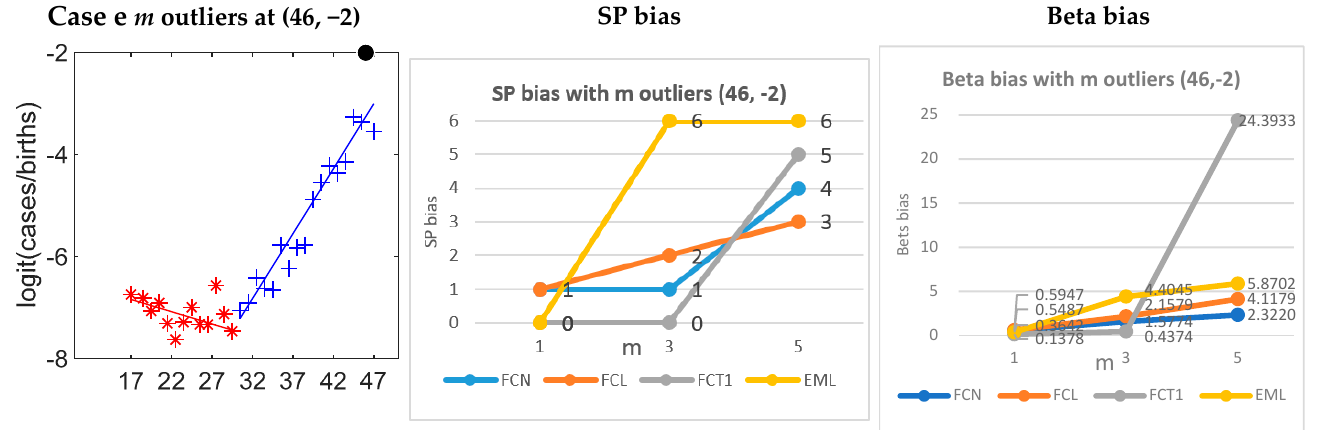
Figure 9. Comparisons of cases (a) and (e); data in case (e) are contaminated by m high-leverage outliers (46, − 2), m = 1, 3, 5.